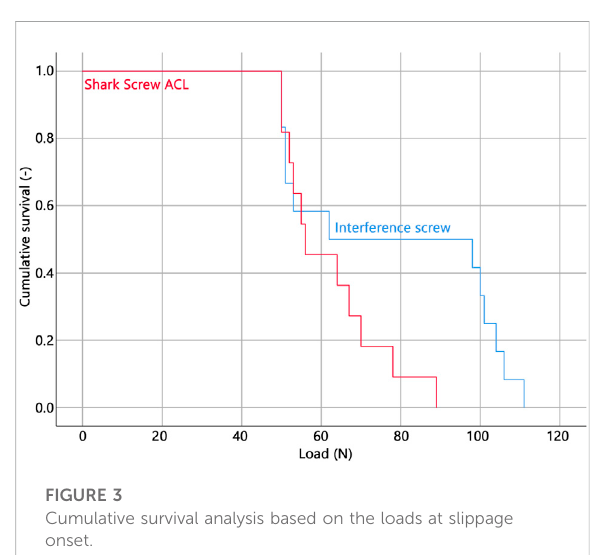
FIGURE 3 Cumulative survival analysis based on the loads at slippage